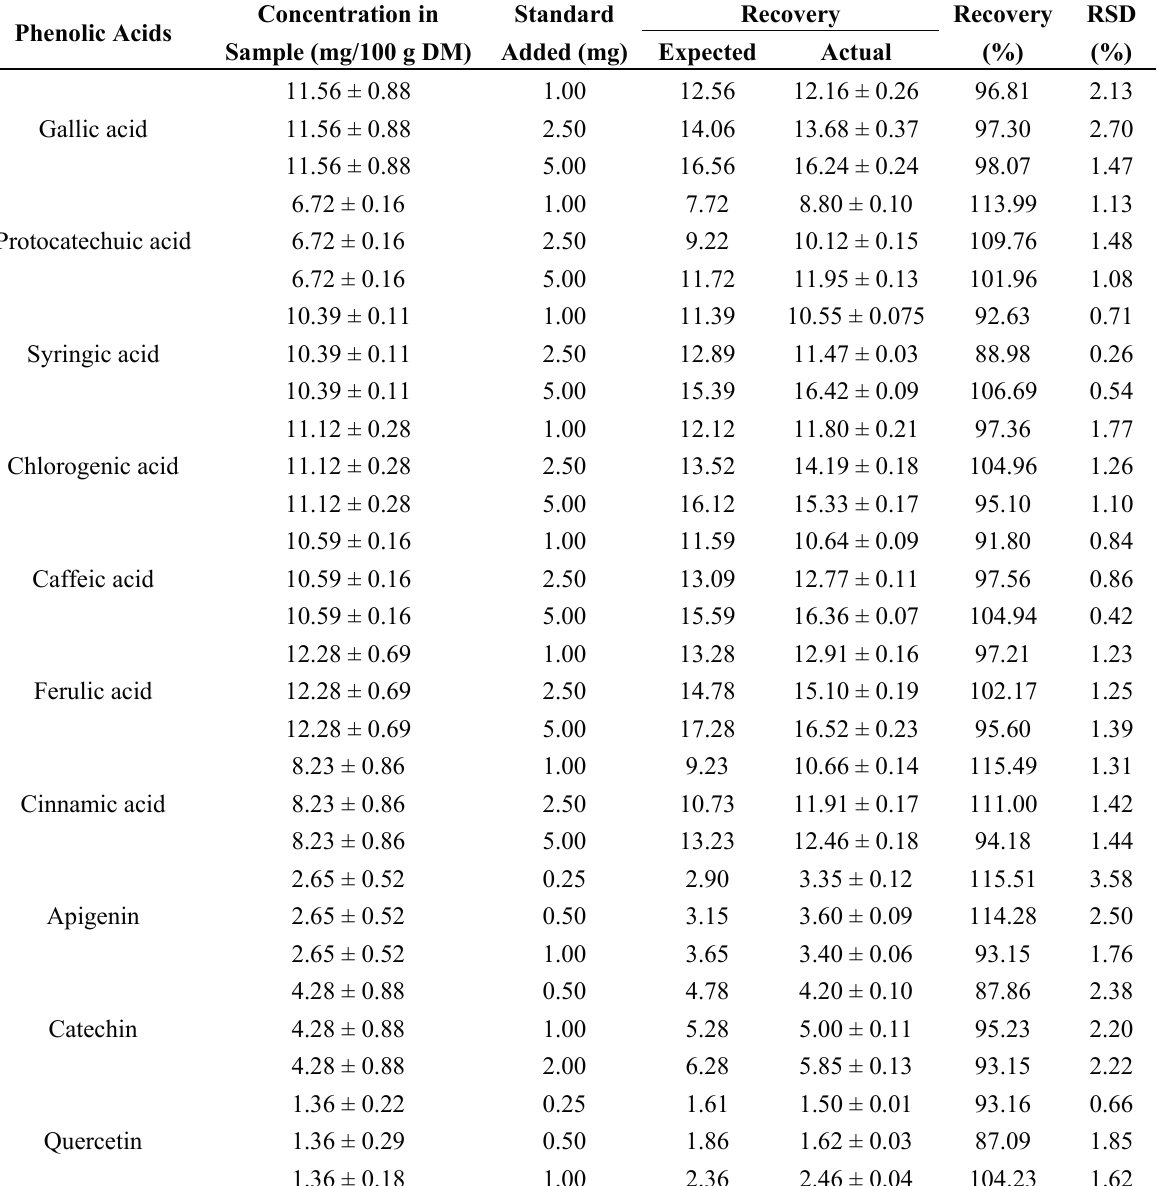
Table 4. Concentration of identified phenolic acids and flavonoids and their recovery test in Hashemi rice bran